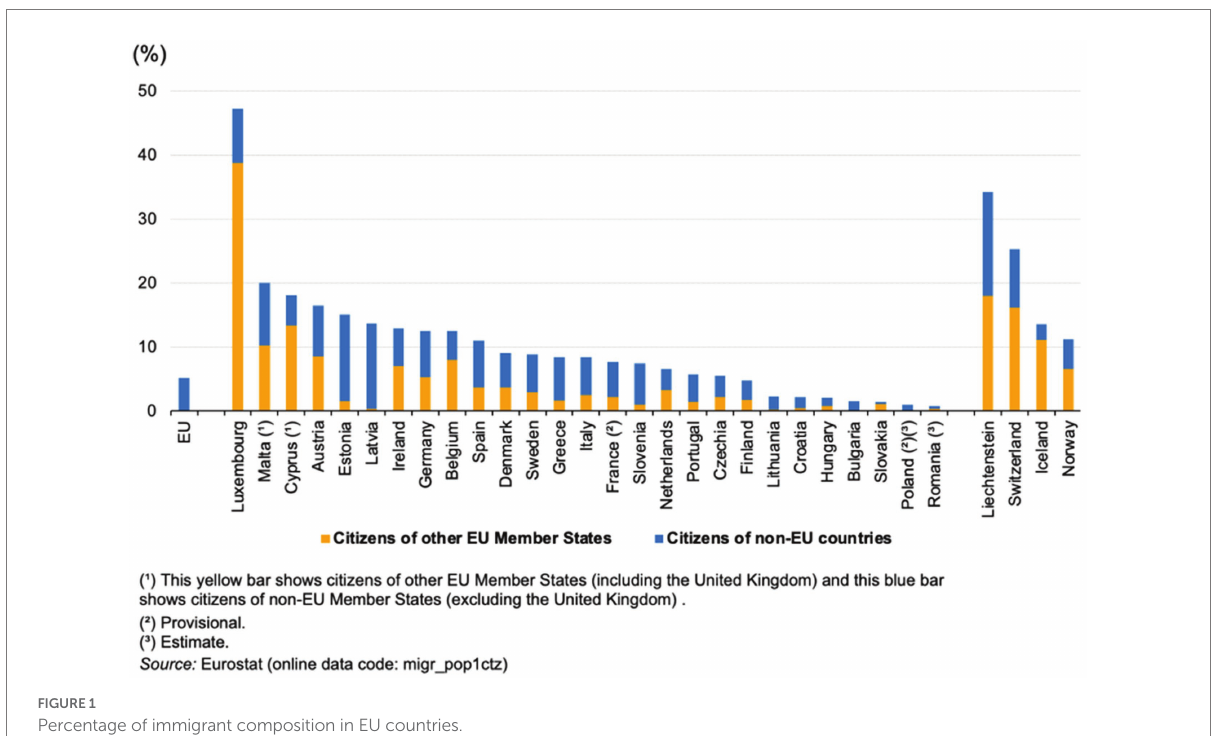
FIGURE 1 Percentage of immigrant composition in EU